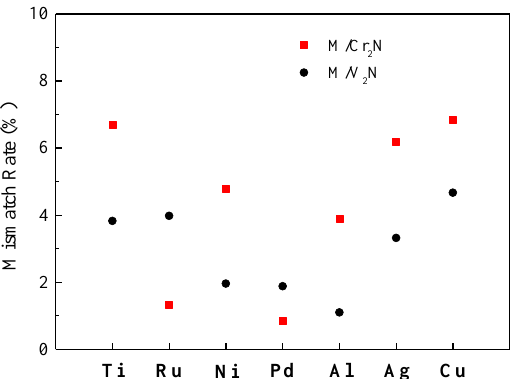
Figure 4. Interfacial mismatch rates calculated for the interface models constructed in this work.